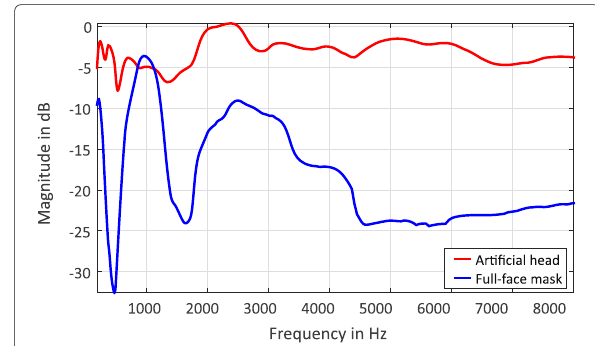
Fig. 2 Frequency response of the full-face mask PanoramaNova (blue) and the artificial head without a full-face mask